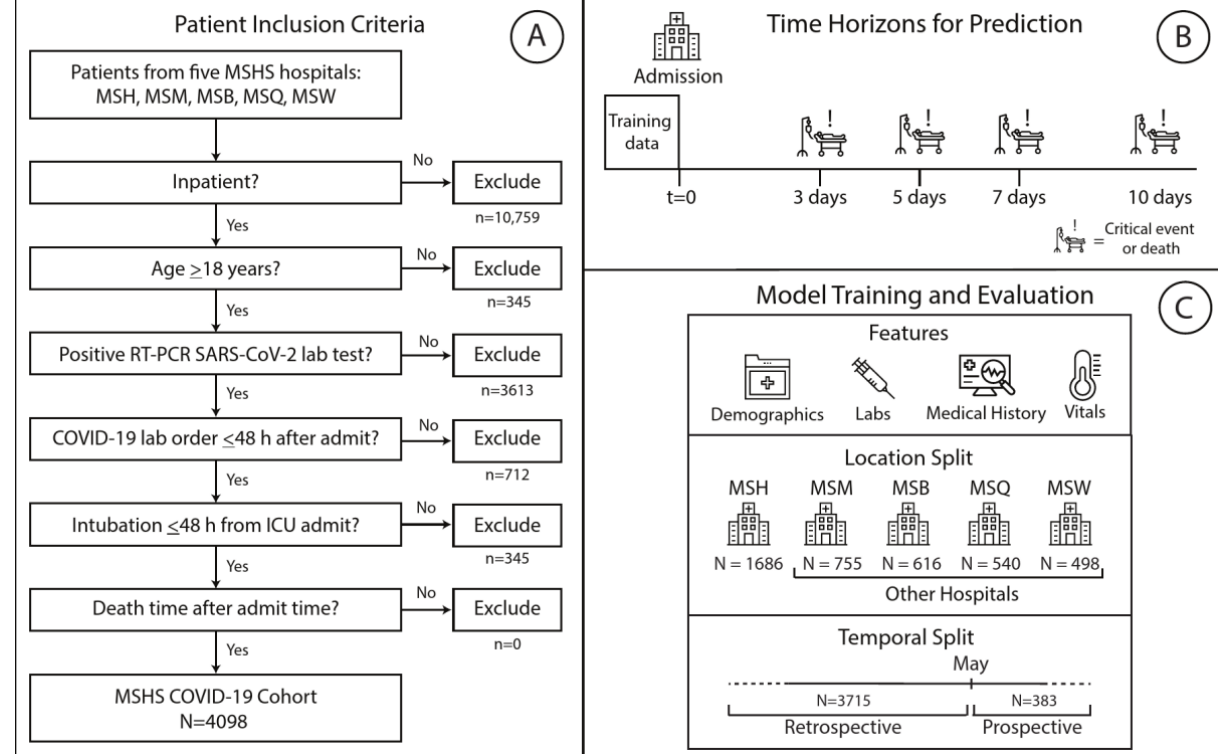
Figure 1. Study design and workflow. (A) Procedure for patient inclusion in our study. (B) Outcomes of interest. We trained the model on data taken at time of admission to predict the likelihood of either mortality or critical event occurrence at 3, 5, 7, and 10 days. (C) Strategy and design of the experiments. Patient clinical data from Mount Sinai Hospital (MSH) before the temporal split (May 1) were used to train and internally validate our XGBoost model in comparison with other baseline models. We then tested the series of XGBoost models on unimputed patient data on patients